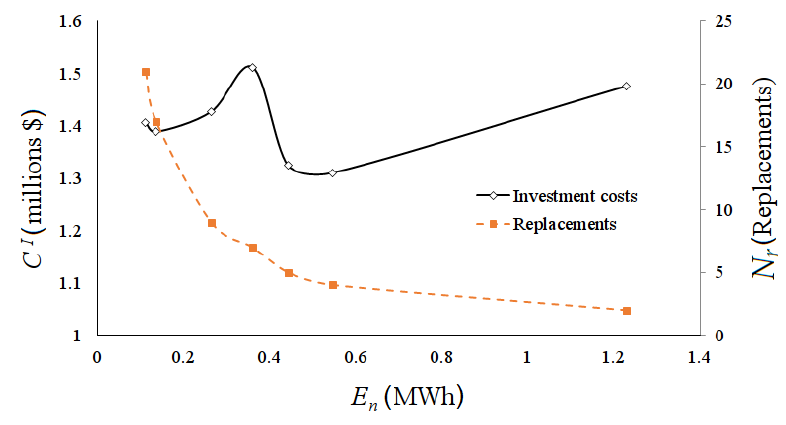
Figure 7. Total BESS investment and replacement cost.